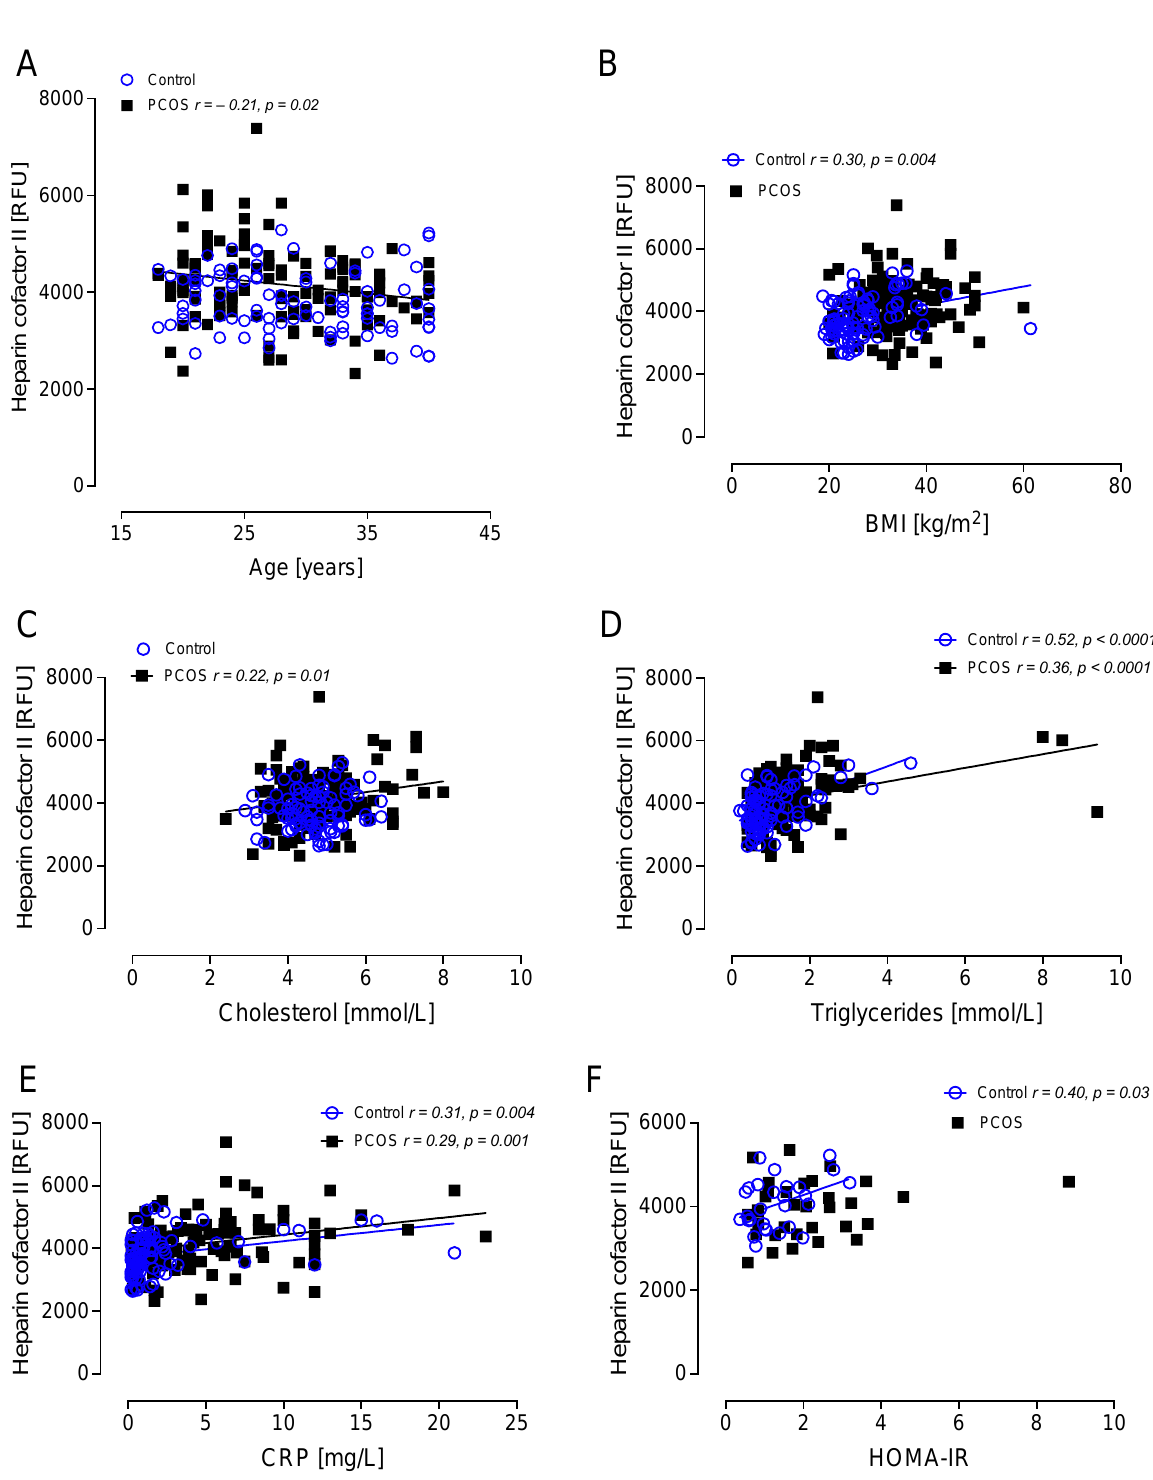
Figure 7. Heparin cofactor II (HCFII) correlated significantly with age in PCOS ( A ), BMI in controls ( B ), cholesterol in PCOS ( C ), triglycerides in controls and PCOS ( D ), CRP in controls and PCOS ( E ), and HOMA-IR in controls ( F ).